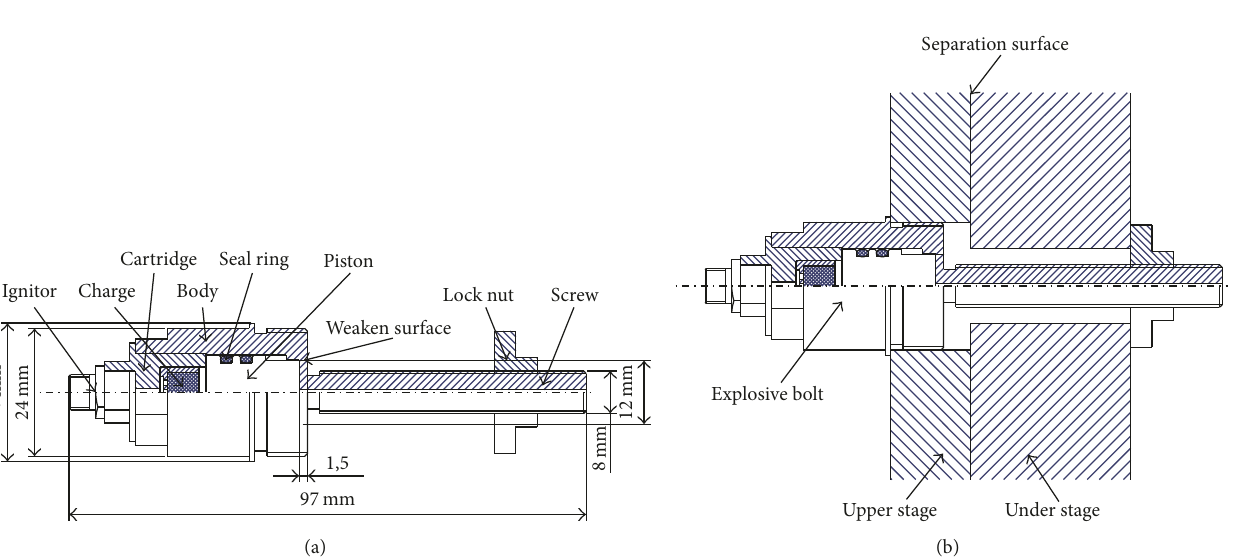
Figure 1: Structural schematic diagrams of shear type explosive bolt: (a) structure composition and (b) installation